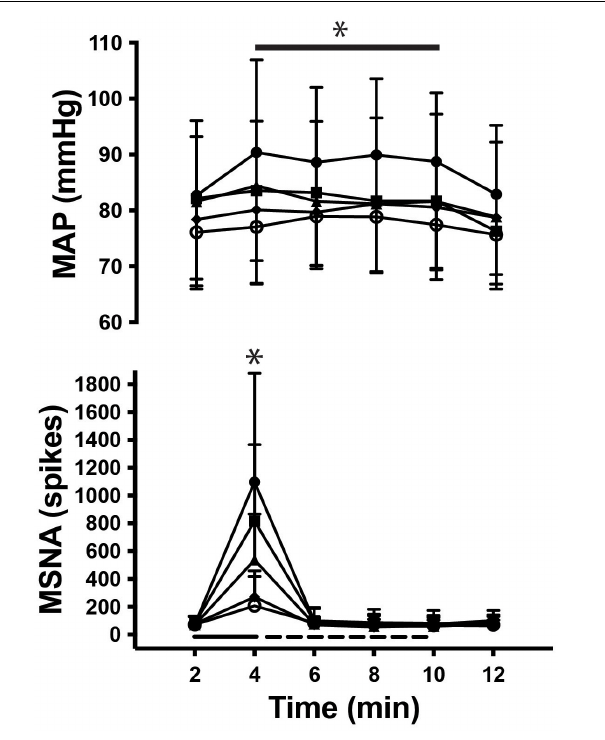
FIGURE 4 | Time course of MSNA and mean arterial pressure (MAP) during rest, contraction ( __ ), post-exercise ischemia ( - - - ) and recovery. Main effects of time are indicated with an asterisk ( ∗ P < 0.05).